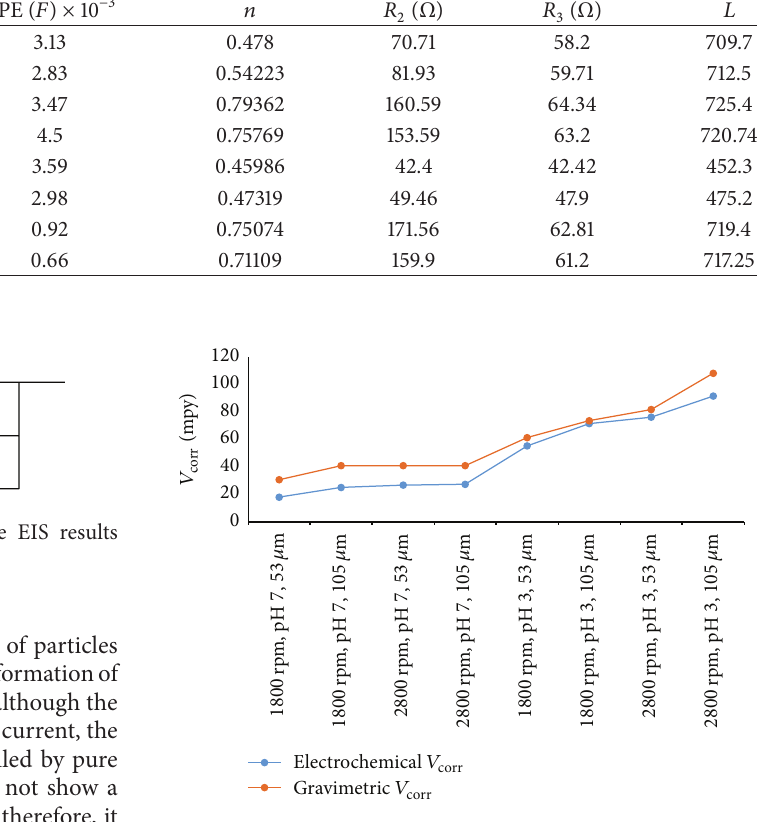
Figure 8: Corrosion rates of AISI 4330 electrode under impinge- ment by NaCl solution containing 10wt.% sand at different flow velocities, particle sizes, and pH values.